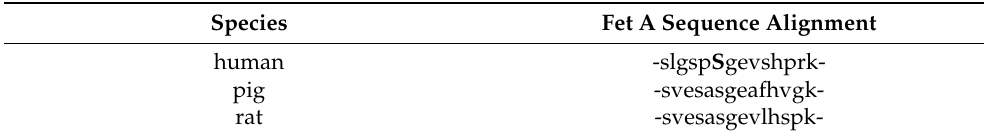
Table 1. Partial Fetuin A sequence alignment of different species (human; pig and rat). The human phospho-peptide was used to generate antibodies against phospho-Ser 312 Fet A (pFet A), bold S indicates Ser 312 in human Fet A. Species Fet A Sequence Alignment human pig